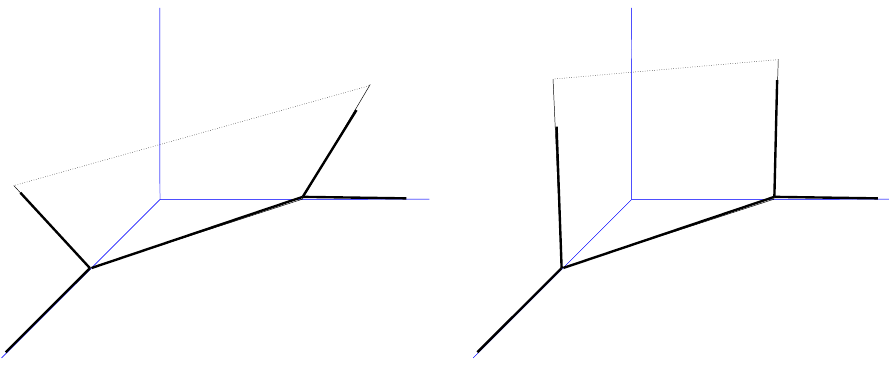
Figure 1 . Relative orientations of the two corners: p = 0 on the left, p = (cid:0) 1 on the right. N = 2 case of [23], the nilpotency-on-vacuum property could have also been derived from the map to the W N =2